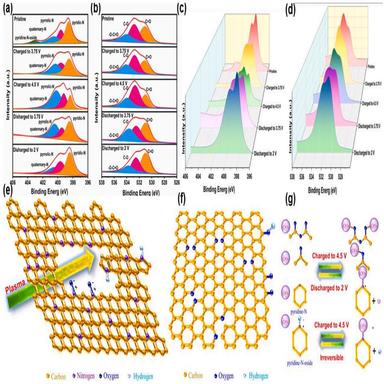
ClO4 − Storage Mechanism and pseudocapacitive processes of NPC-60. a-d) ex-XPS patterns of N1s and O1s in the charging/discharging states of NPC-60 in different potentials (pristine, 3.75, 4.5, 3.75, and 2.0 V). e, f) Schematic diagram of edges/pores/defects/functional groups generated by NH3 plasma treatment. g) Pseudocapacitive processes of NPC-60.